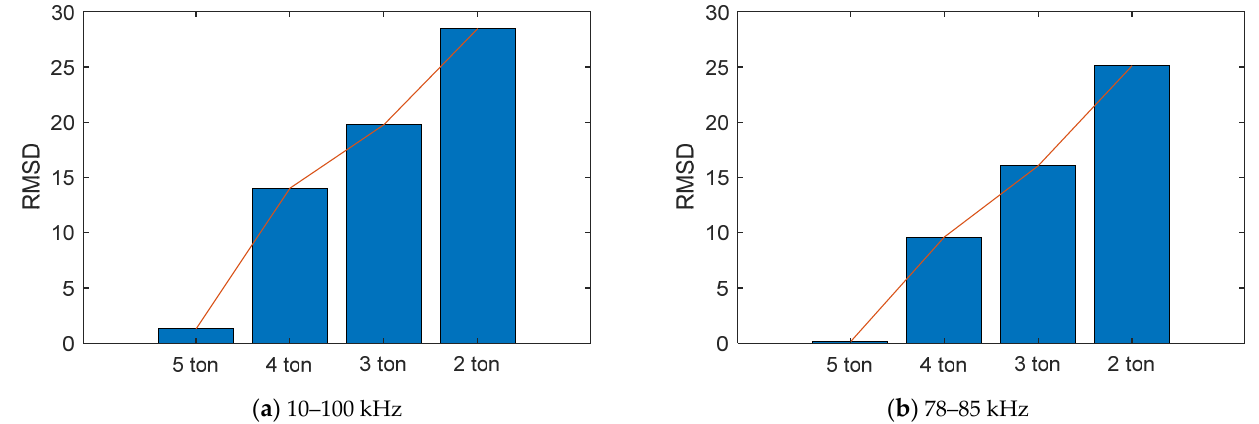
Buildings 2021 , 11 , x FOR PEER REVIEW Figure 13. The RMSD index of the electromechanical impedance of the two-point mount PZT interface. Figure 13. The RMSD index of the electromechanical impedance of the two-point mount PZT interface. Figure 13. The RMSD index of the electromechanical impedance of the two-point mount PZT interface.